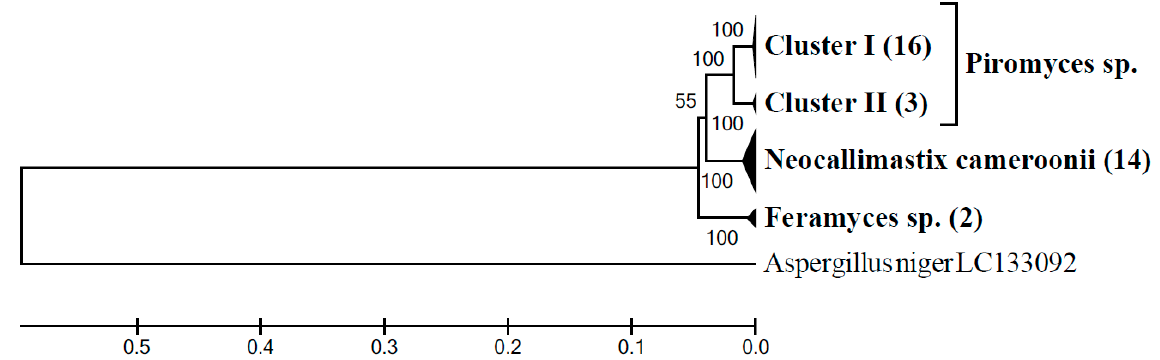
Figure 5. Phylogenetic relationships of anaerobic fungal LSU gene sequences generated from the sample G3AH inferred using the UPGMA method with bootstrap values from 1000 replications. The analysis involved a total of 45 nucleotide sequences (35 sequences generated from the G3AH sample, 9 sequences of the cultured genera of anaerobic fungi ( Piromyces sp. MK775335, KY368606, and KY368602 , N. camerooni NG060329, KR920745, and MG992493, F. austinii MG584215, MG584217, and MG605676) plus 1 outgroup sequence. An uncompressed phylogenetic tree is shown in Supplementary material (Figure S4).